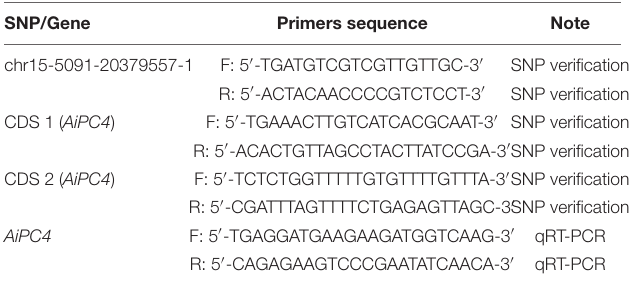
TABLE 1 | Sequences of primers used in this